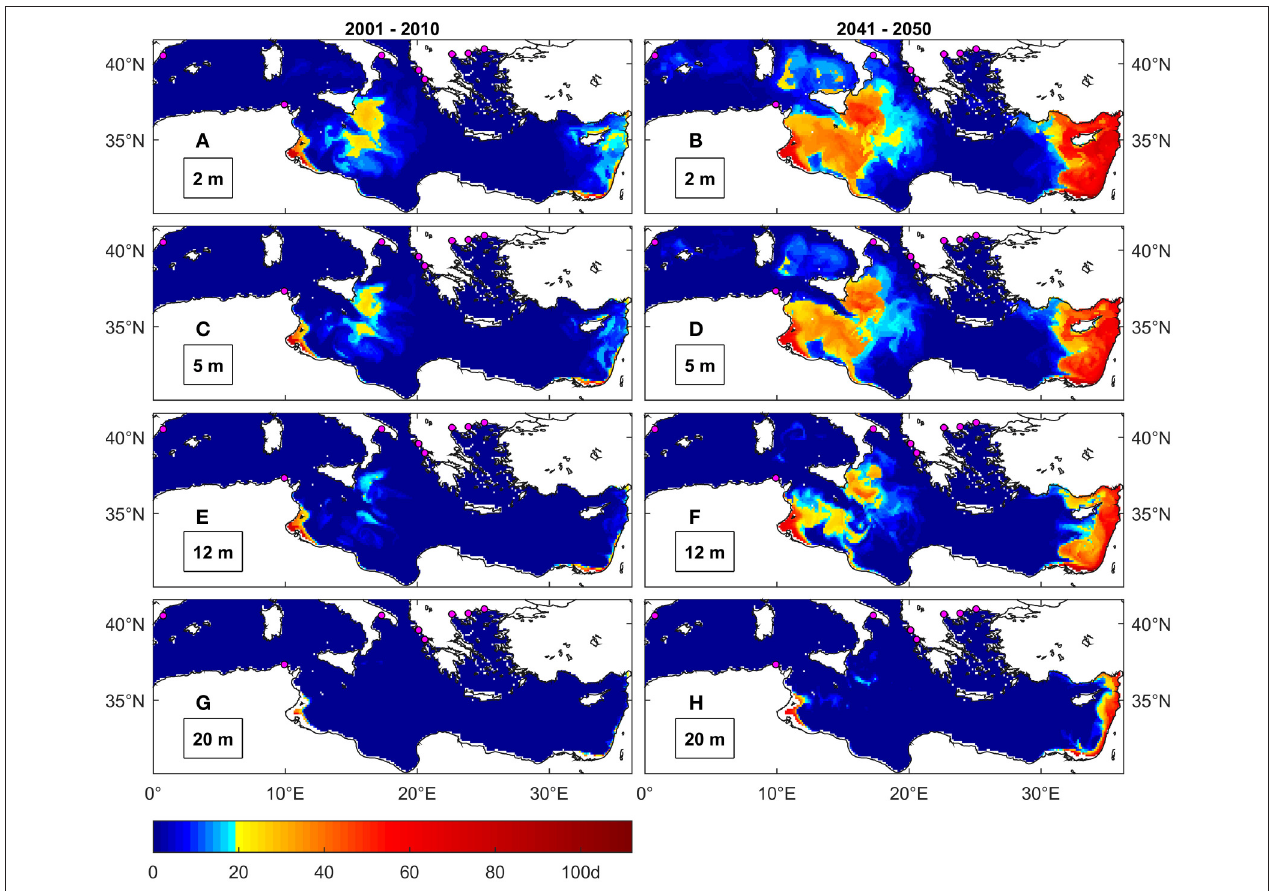
FIGURE 7 | Maximal number of consecutive days above 30 ◦ C under present (A,C,E,G) and future (B,D,F,H) conditions at different depths. The colormap is modified to highlight the threshold of 20 days identified by Anestis et al. (2007) as lethal for M. galloprovincialis from the Thermakios gulf (Greece). Magenta dots are locations of mussel farming facilities (Rodrigues et al.,